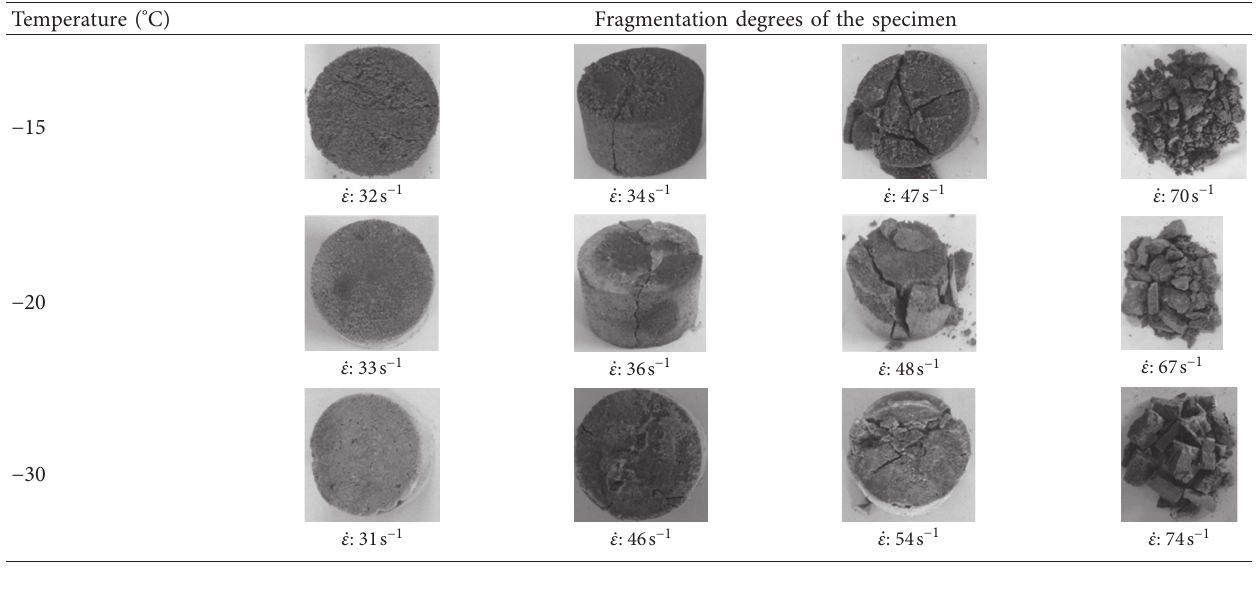
Table 6: Fragmentation degrees under different